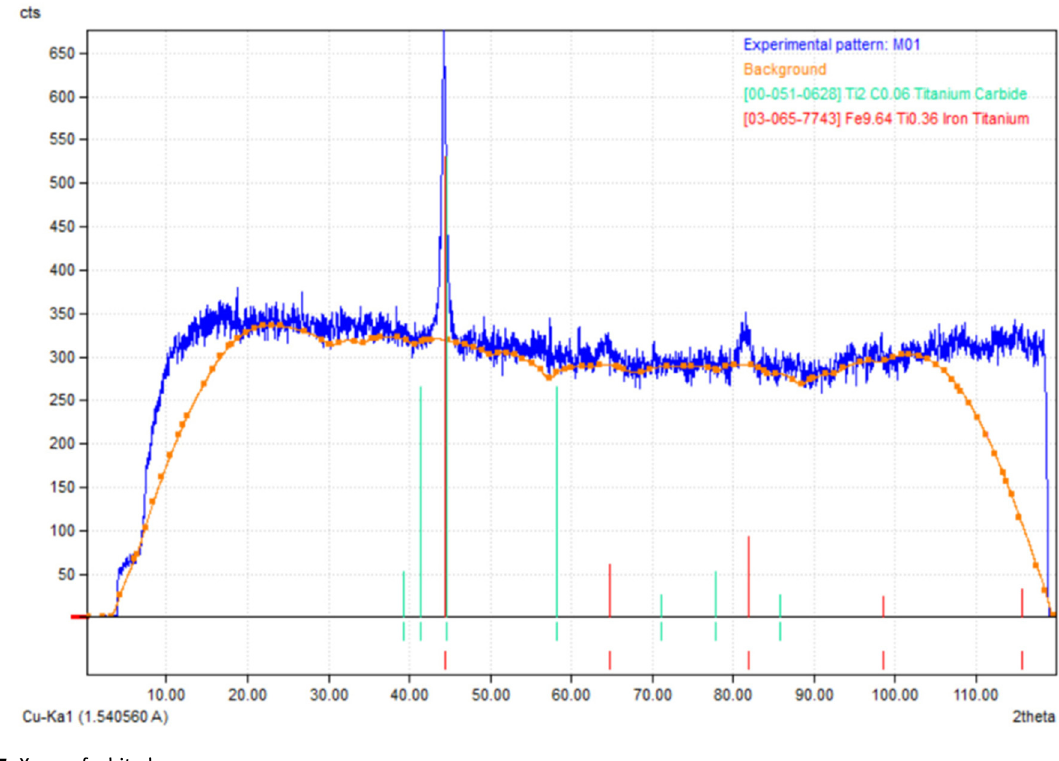
Figure 7: X - ray of white layer.